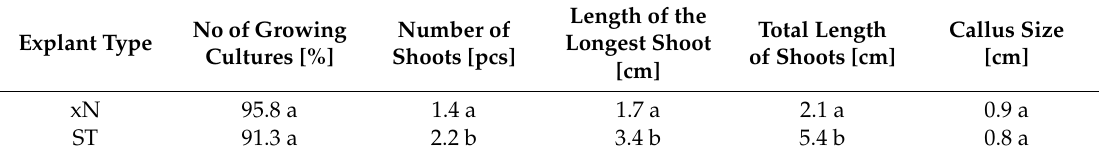
Table 7. Growth of mountain mulberry ‘Kenmochi’ in vitro cultures established from shoot-tip (ST) and nodal (xN) explants on standard (AxB)